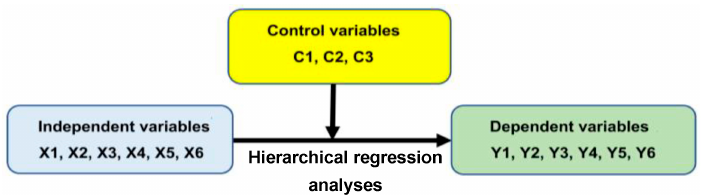
Figure 10. Relationships between independent variables X1 through X6, dependent variables Y1 through Y6, and control variables C1 through C3.